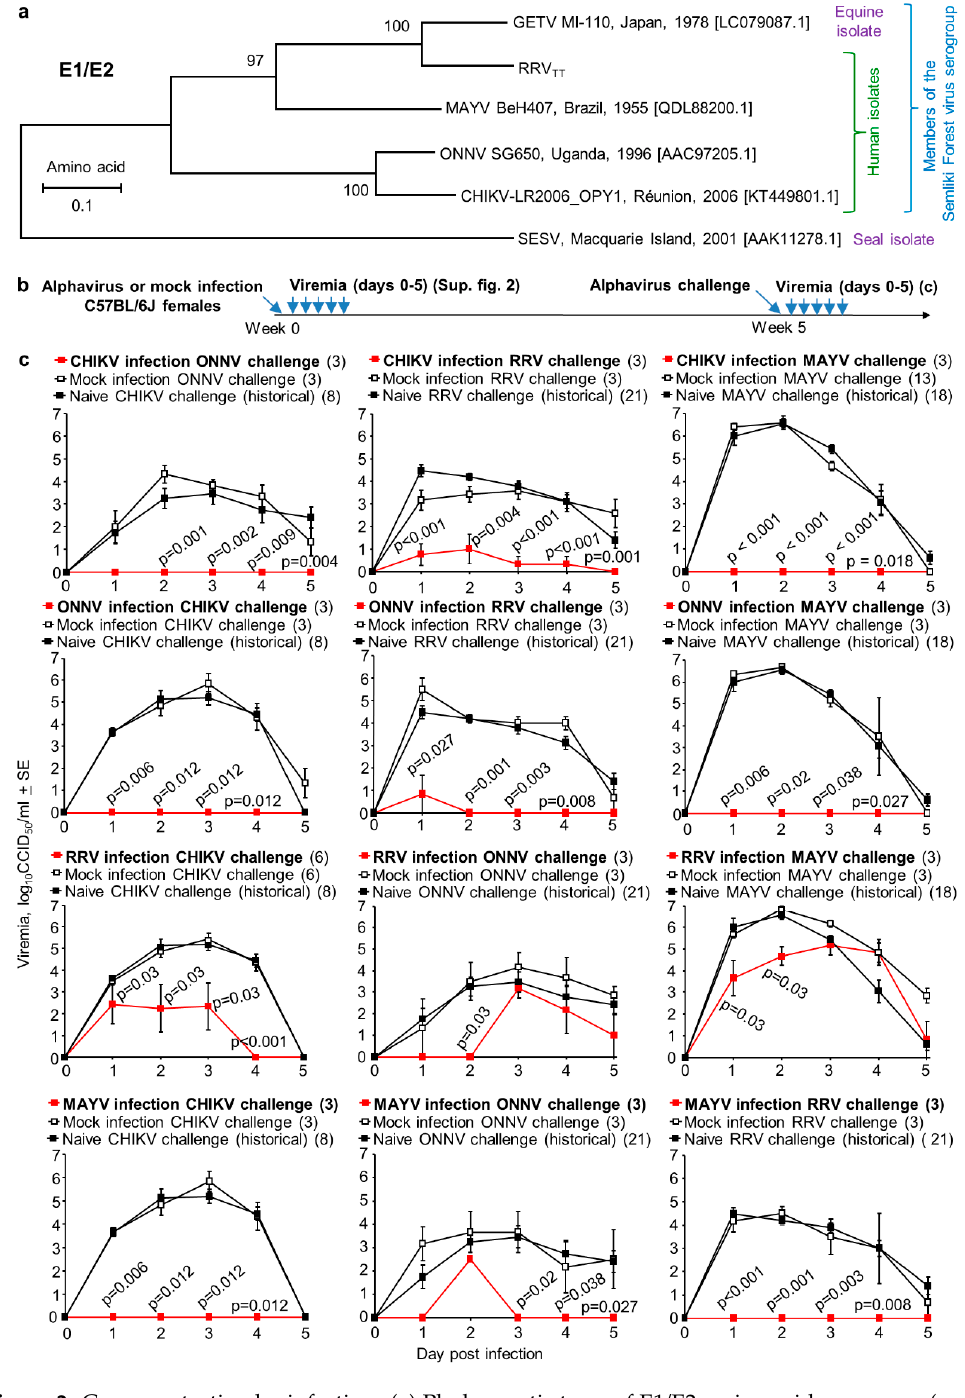
Figure 2. Cross-protection by infection. ( a ) Phylogenetic trees of E1 / E2 amino acid sequences (as in Supplementary Figure S3a of arthritogenic alphaviruses used herein, with Southern Elephant Seal virus (SESV) [84] used as an outgroup; ( b ) Timeline of infection, challenge and viremia determinations; ( c ) Heterologous cross-protection. Black lines represent mock-infected or naïve mice challenged with the indicated virus; red lines represent viremia after infection and heterologous challenge. Numbers in brackets represent mouse numbers. Statistics by Kolmogorov–Smirnov tests taking Mock (white fill) and Naïve (black fill) together, and comparing with heterologous challenge group